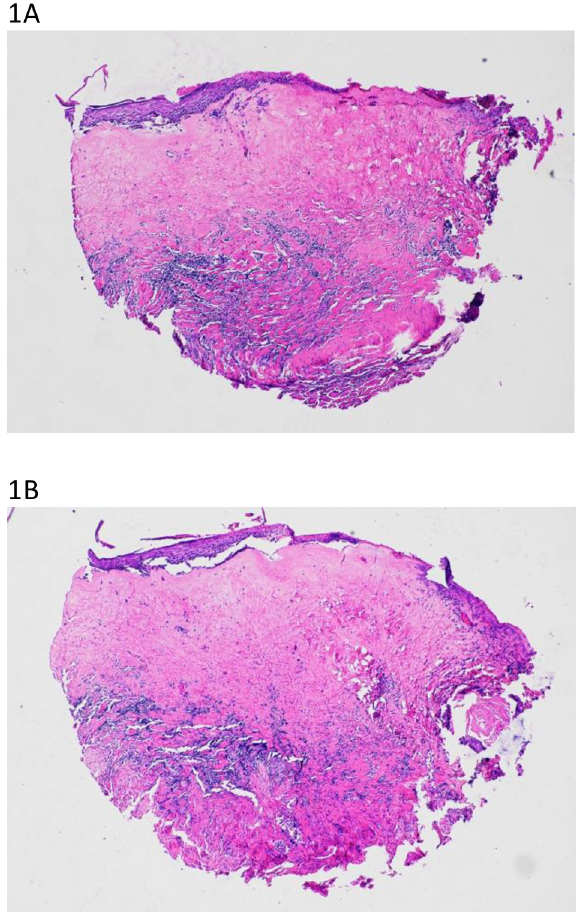
Fig 1. TMA cores. Sectioned before (A) and after (B) RNA isolation showing persistent histologic features typical of LS to include dense subepithelial hyalinization with lichenoid lymphoplasmacytic infiltrate, thinning of the squamous epithelium with focal hyperkeratosis and attenuation of the basal